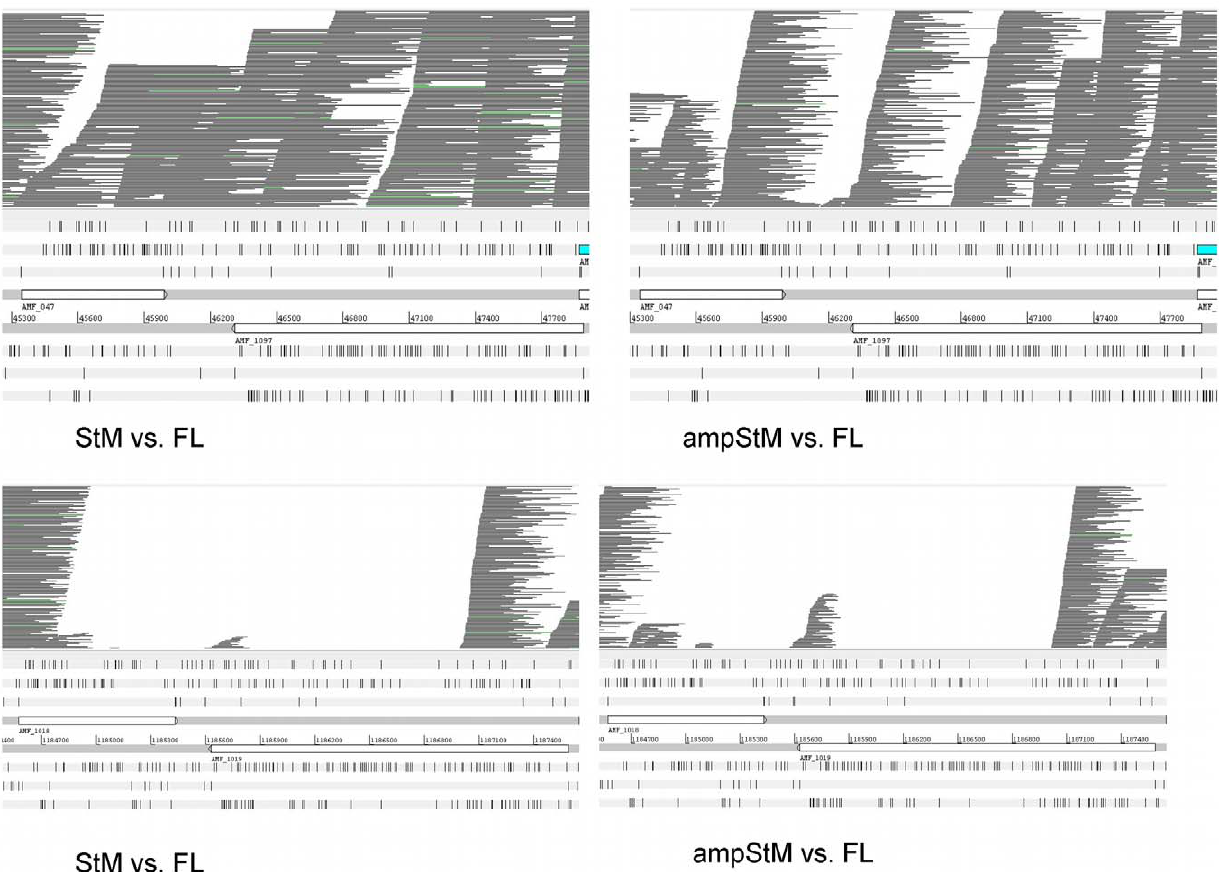
Figure 2. Detection of shared and different pseudogenes between strains of A.marginale . Top panel: Mosaik alignment of sequencing reads from the StM strain with the FL strain as reference; left is nonamplified StM genomic DNA, right is amplified St. Maries genomic DNA (the region of the FL strain encoding the msp2/msp3 gene pair AMF_047/AMF_1097 is shown). Lower panel: alignment of reads over the msp2/msp3 gene pair AMF_1018/AMF_1019. The lack of corresponding genes in the St. Maries strain is revealed by gaps in coverage.